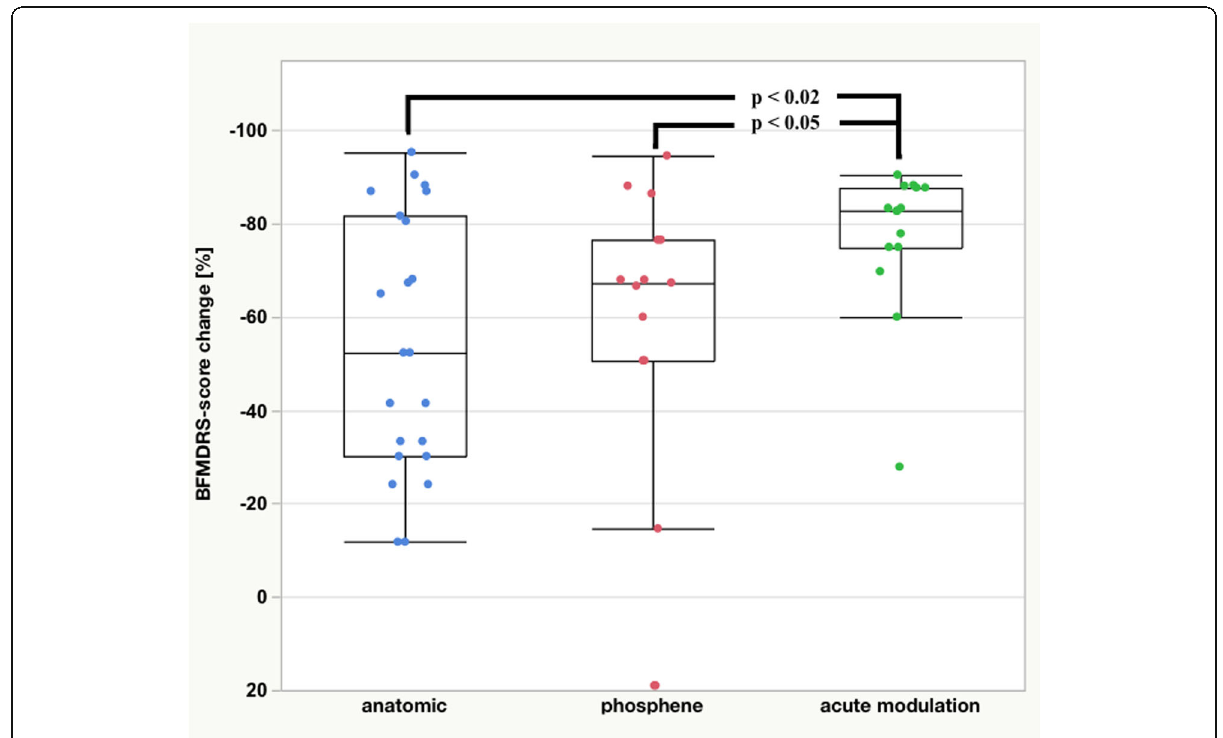
Fig. 2 Reduction in the Burke-Fahn-Marsden Dystonia Rating Scale (BFMDRS) motor score after 3 years, depending on choice criteria for contact selection (Wilcoxon